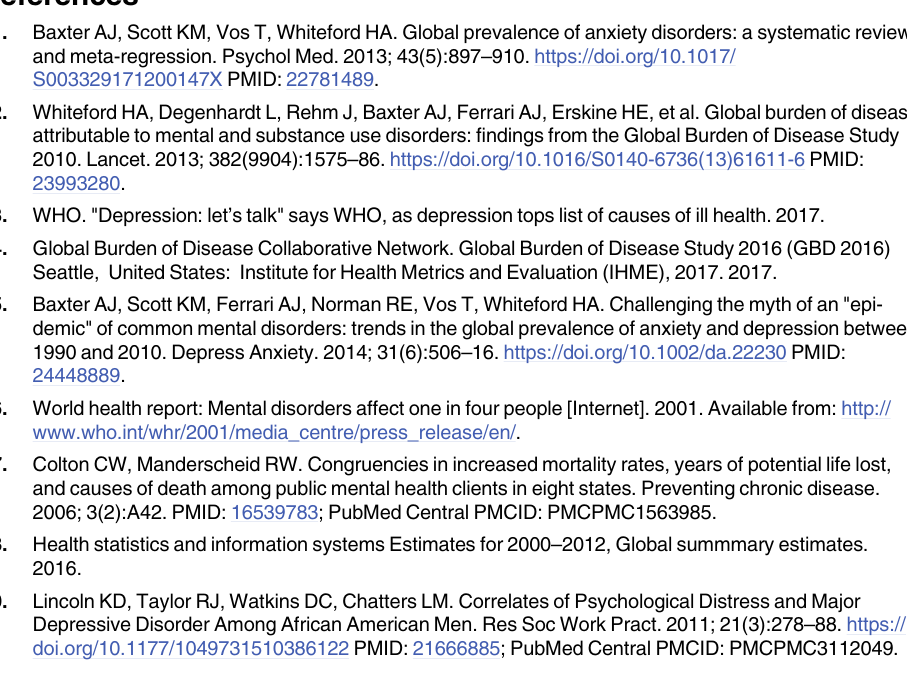
S2 File. Table 2 for Fig